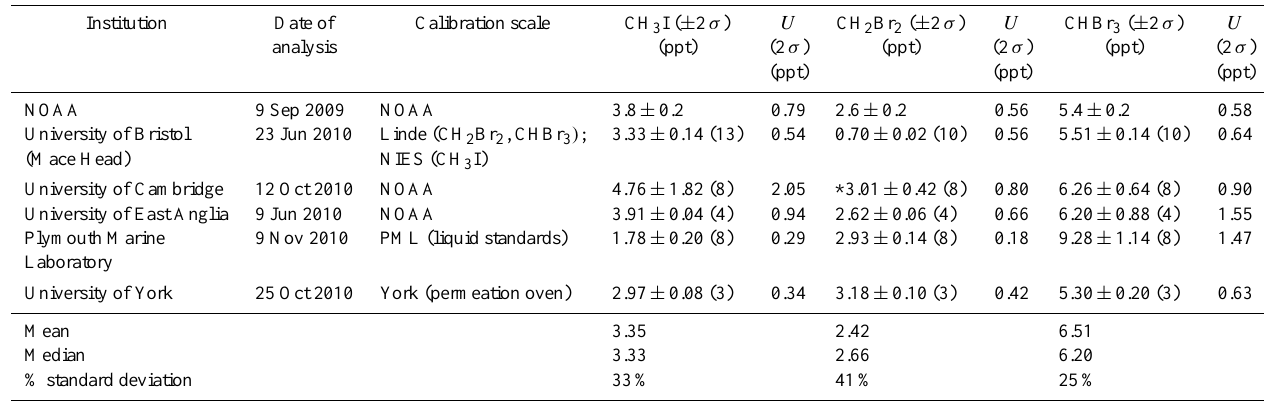
Table 1. Summary of CH 3 I, CH 2 Br 2 and CHBr 3 mixing ratios as assigned by NOAA and determined by the individual UK research laboratories, together with the 2 σ precision in the inter-calibration analyses and the estimated 2 σ (95.4% confidence interval) overall uncertainty in the reported mixing ratio (incorporating both systematic uncertainties and precision), U . The number of data points used to derive the reported mixing ratio is given in